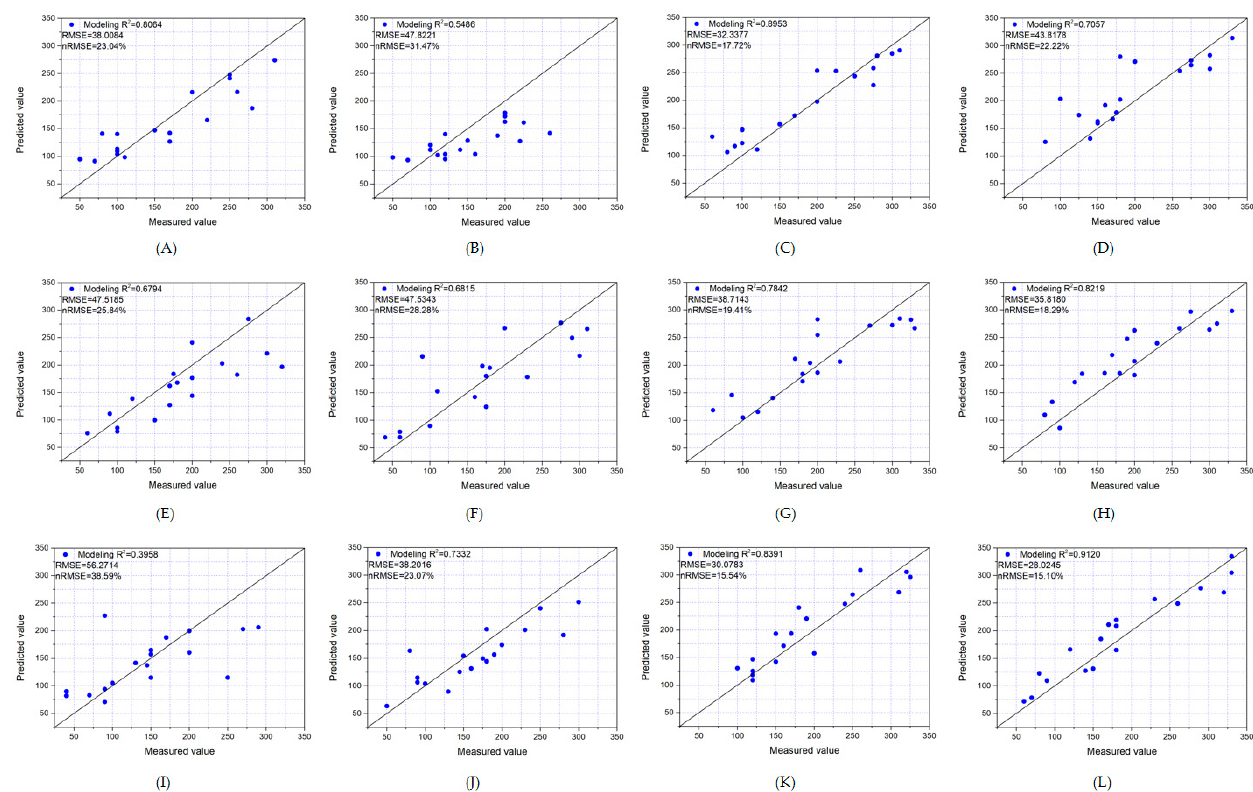
Figure 13. Prediction models for tiller number of different winter wheat varieties under the same nitrogen fertilizer treatment and different density treatments. ( A – D ) Variety 1; ( E – H ) variety 2; and ( I – L ) variety 3. There were four nitrogen treatments: ( A , E , I ) N1; ( B , F , J ) N2; ( C , G , K ) N3; and ( D , H , L ) N4.